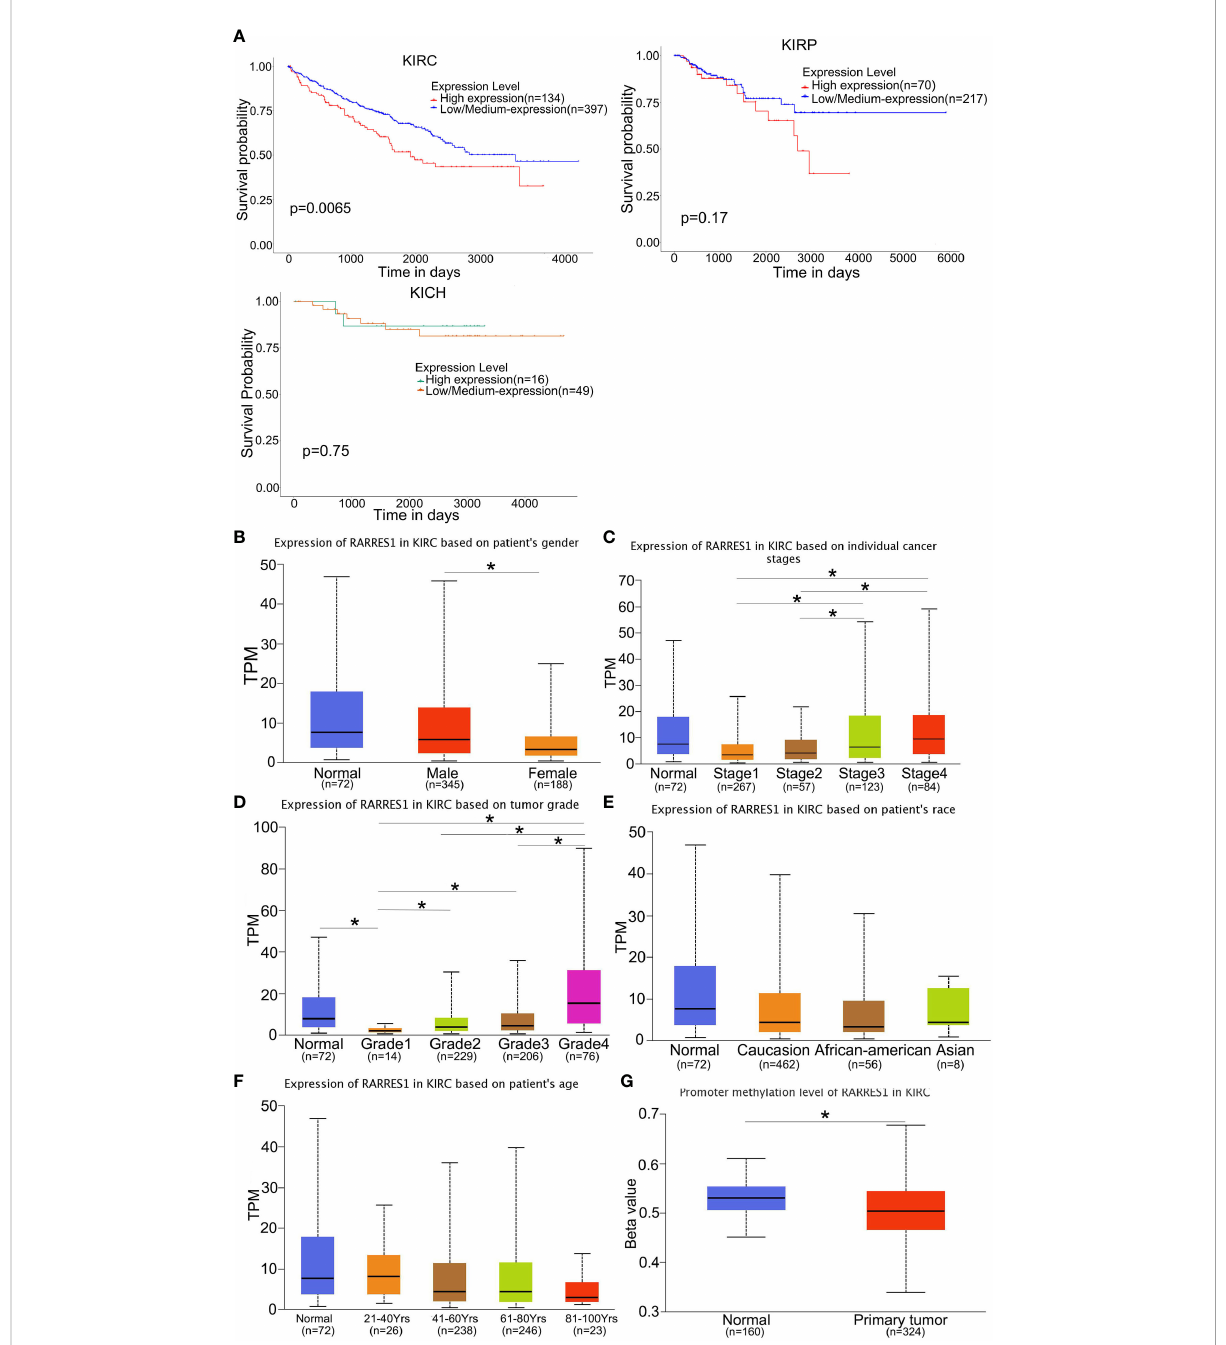
FIGURE 1 RARRES1 expression in KIRC. (A) The effect of the RARRES1 expression level on KIRC, KIRP and KICH patient survival was assessed by Kaplan – Meier survival analysis. (B – G) The differential expression of RARRES1 in KIRC patients. RARRES1 expression in different subgroups. (B) The expression of RARRES1 in male patients was signi fi cantly different from that in female patients (p=0.00144). (C) The RARRES1 expression level in the stage 1 subgroup was signi fi cantly different from those in the stage 3 (p=0.037) and stage 4 (p=0.0017) subgroups. The RARRES1 expression level in the stage 2 subgroup was signi fi cantly different from those in the stage 3 (p=0.039) and stage 4 (p=0.0056) subgroups. (D) RARRES1 expression in different tumor grades. (E) Expression of RARRES1 in KIRC based on race. RARRES1 expression in normal controls was not signi fi cantly different from that in Caucasian, African-American and Asian patients (p>0.05). (F) Expression of RARRES1 in KIRC based on age. There was no signi fi cant difference in RARRES1 expression among the groups (p>0.05). (G) The promoter methylation level in the RARRES1 gene was signi fi cantly decreased compared with that in normal controls (p < 0.0001) (TPM, transcripts per million).